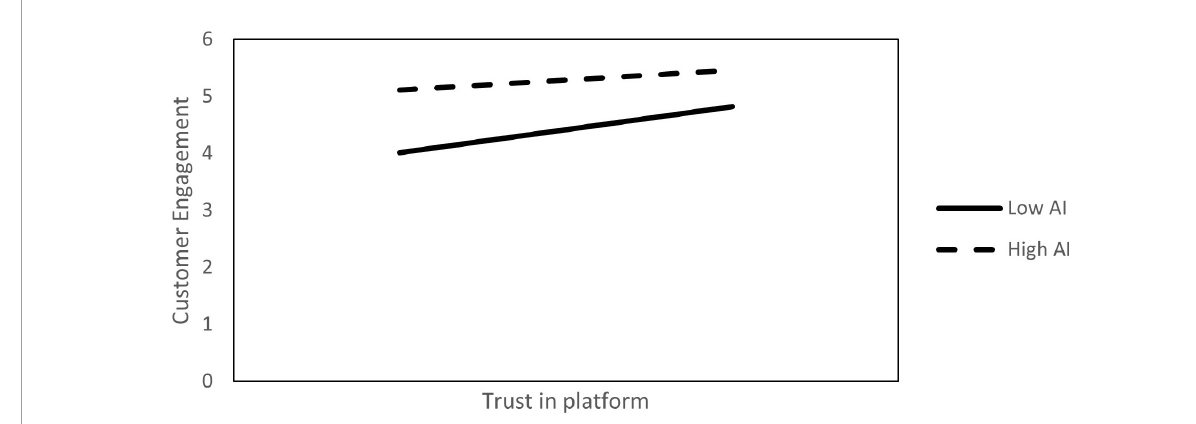
FIGURE3 The moderation effect of AI on trust in the platform and customer engagement.